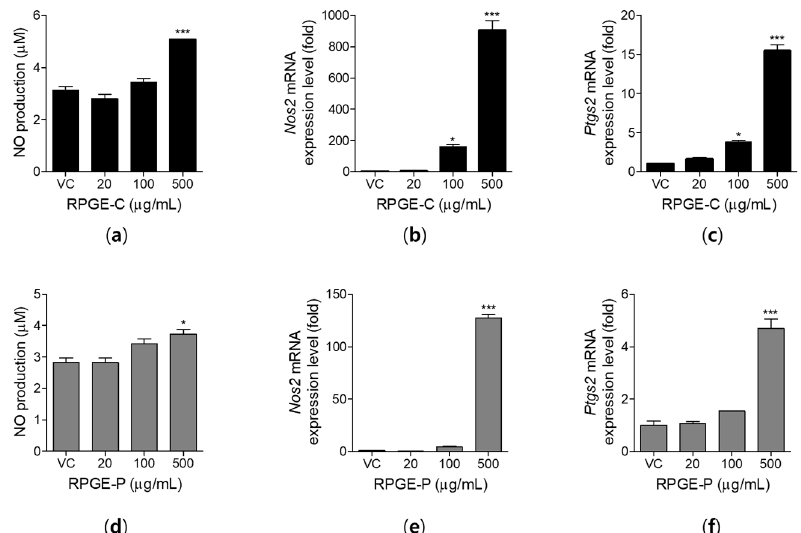
Figure 3. Effect of RPGE on NO production and related mRNA expression in RAW 264.7 cells. ( a – c ) RPGE-C; (d – f) RPGE-P. ( a , d ) NO production; ( b , e ) Nos2 mRNA expression level; ( c , f ) Ptgs2 mRNA expression level. NO, Nitric oxide. All gene expression values were normalized to Actb , and the results were expressed as relative values to that of the VC, which is set to 1. The data are represented as the mean ± SEM. *p < 0.05, **p < 0.01, and ***p < 0.001 when compared with the VC.